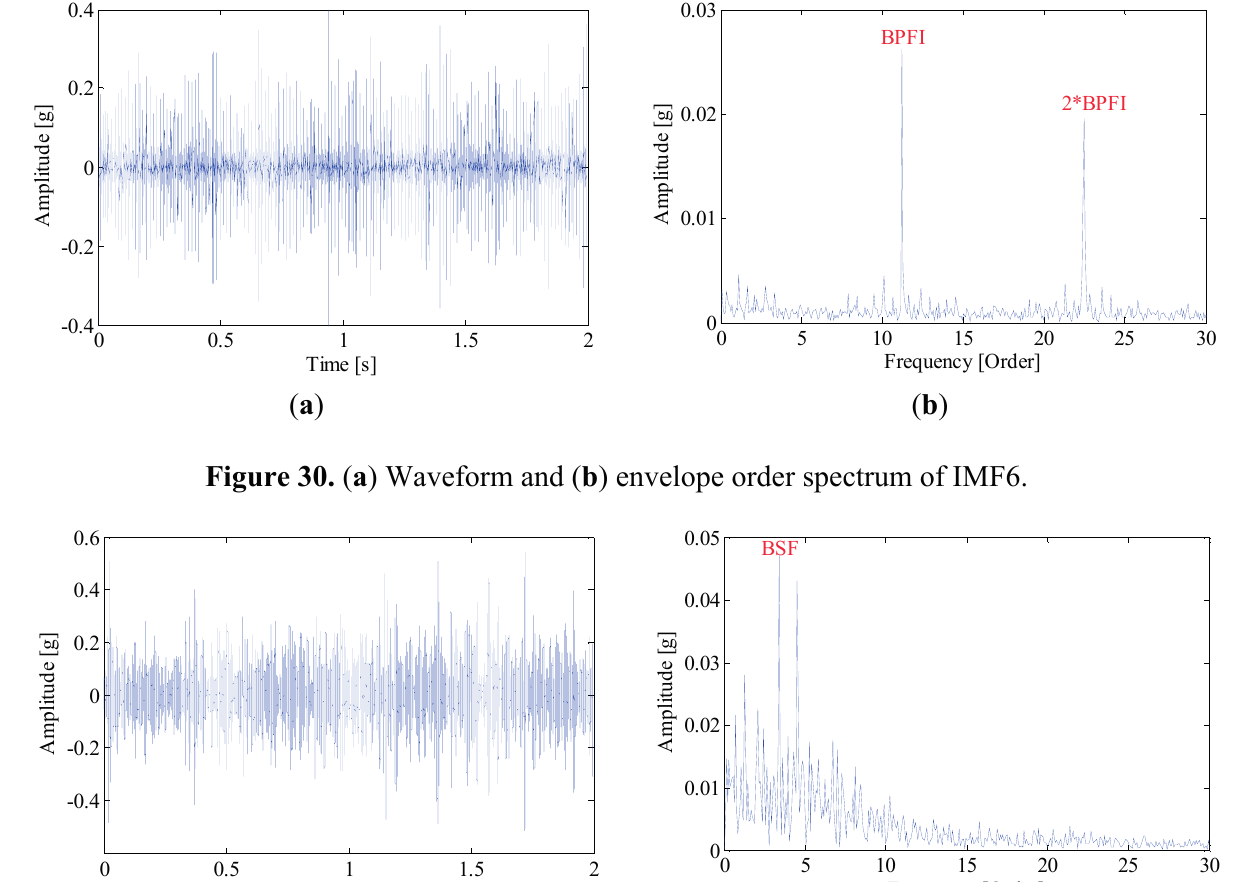
Figure 29. ( a ) Waveform and ( b ) envelope order spectrum of IMF1.